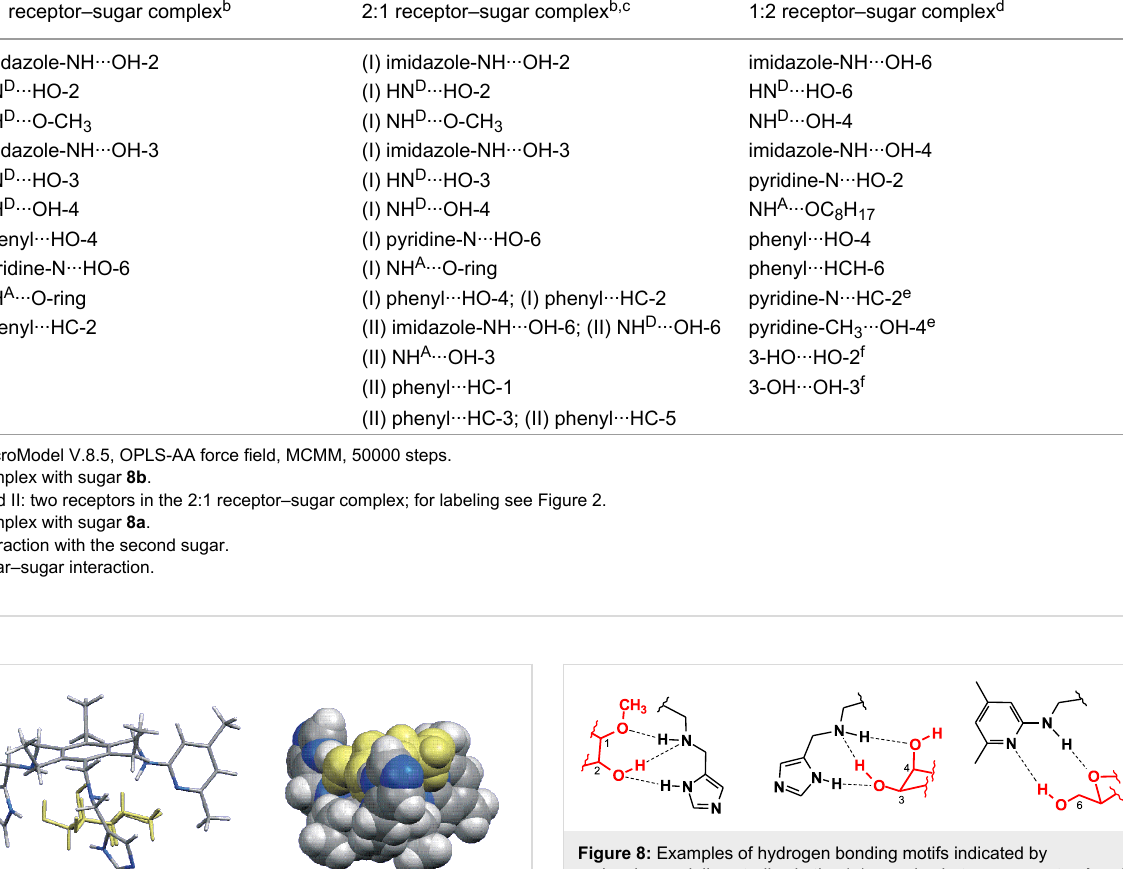
Table 4: Examples of noncovalent interactions indicated by molecular modeling calculations a for the complexes formed between receptor 4 and sugar 8a or 8b . 1:1 receptor–sugar complex b 2:1 receptor–sugar complex b,c